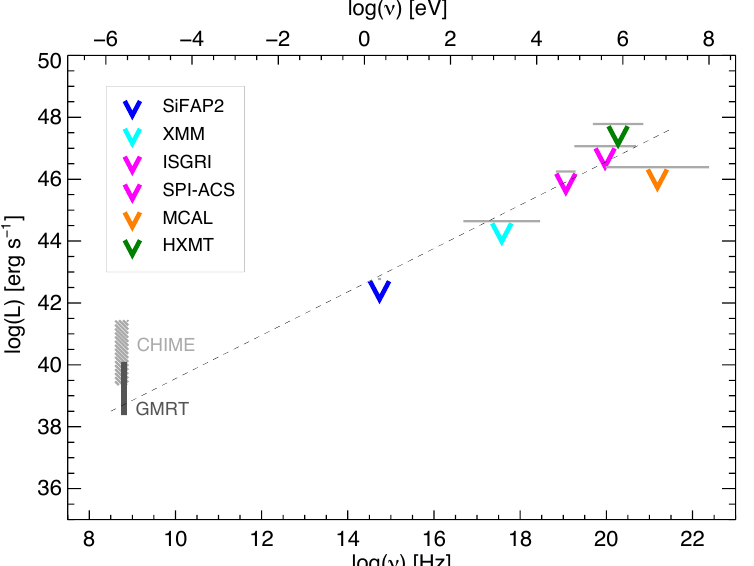
Figure 6. FRB 20180916B burst luminosity vs frequency diagram throughout the electromagnetic spectrum. The CHIME (400–800 MHz) and Giant Metrewave Radio Telescope (550–750 MHz) luminosity range are shown as grey areas (from [47,54]). Adapted from the MWL campaign reported by